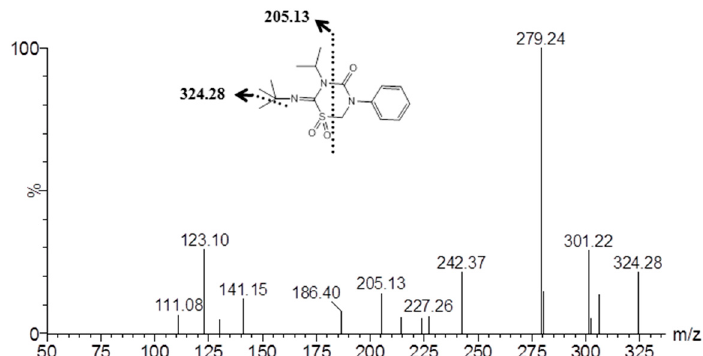
Figure 7. Fragment ion spectrum of the metabolite buprofezin sulfone. The dotted line and the arrow shows the fragment ions of buprofezin sulfone at [324.28] + and [205.13] + .